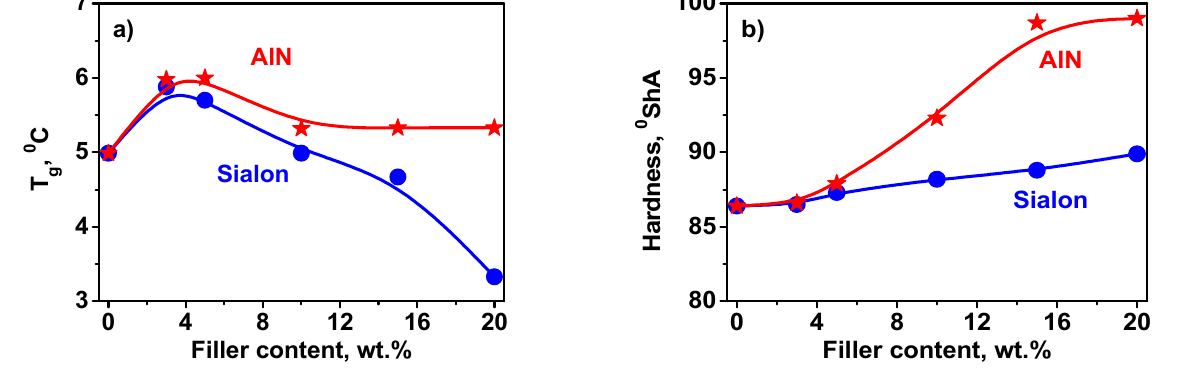
Figure 4. Glass transition T g : ( a ) and hardness of coatings, ( b ) as a function of filler content.